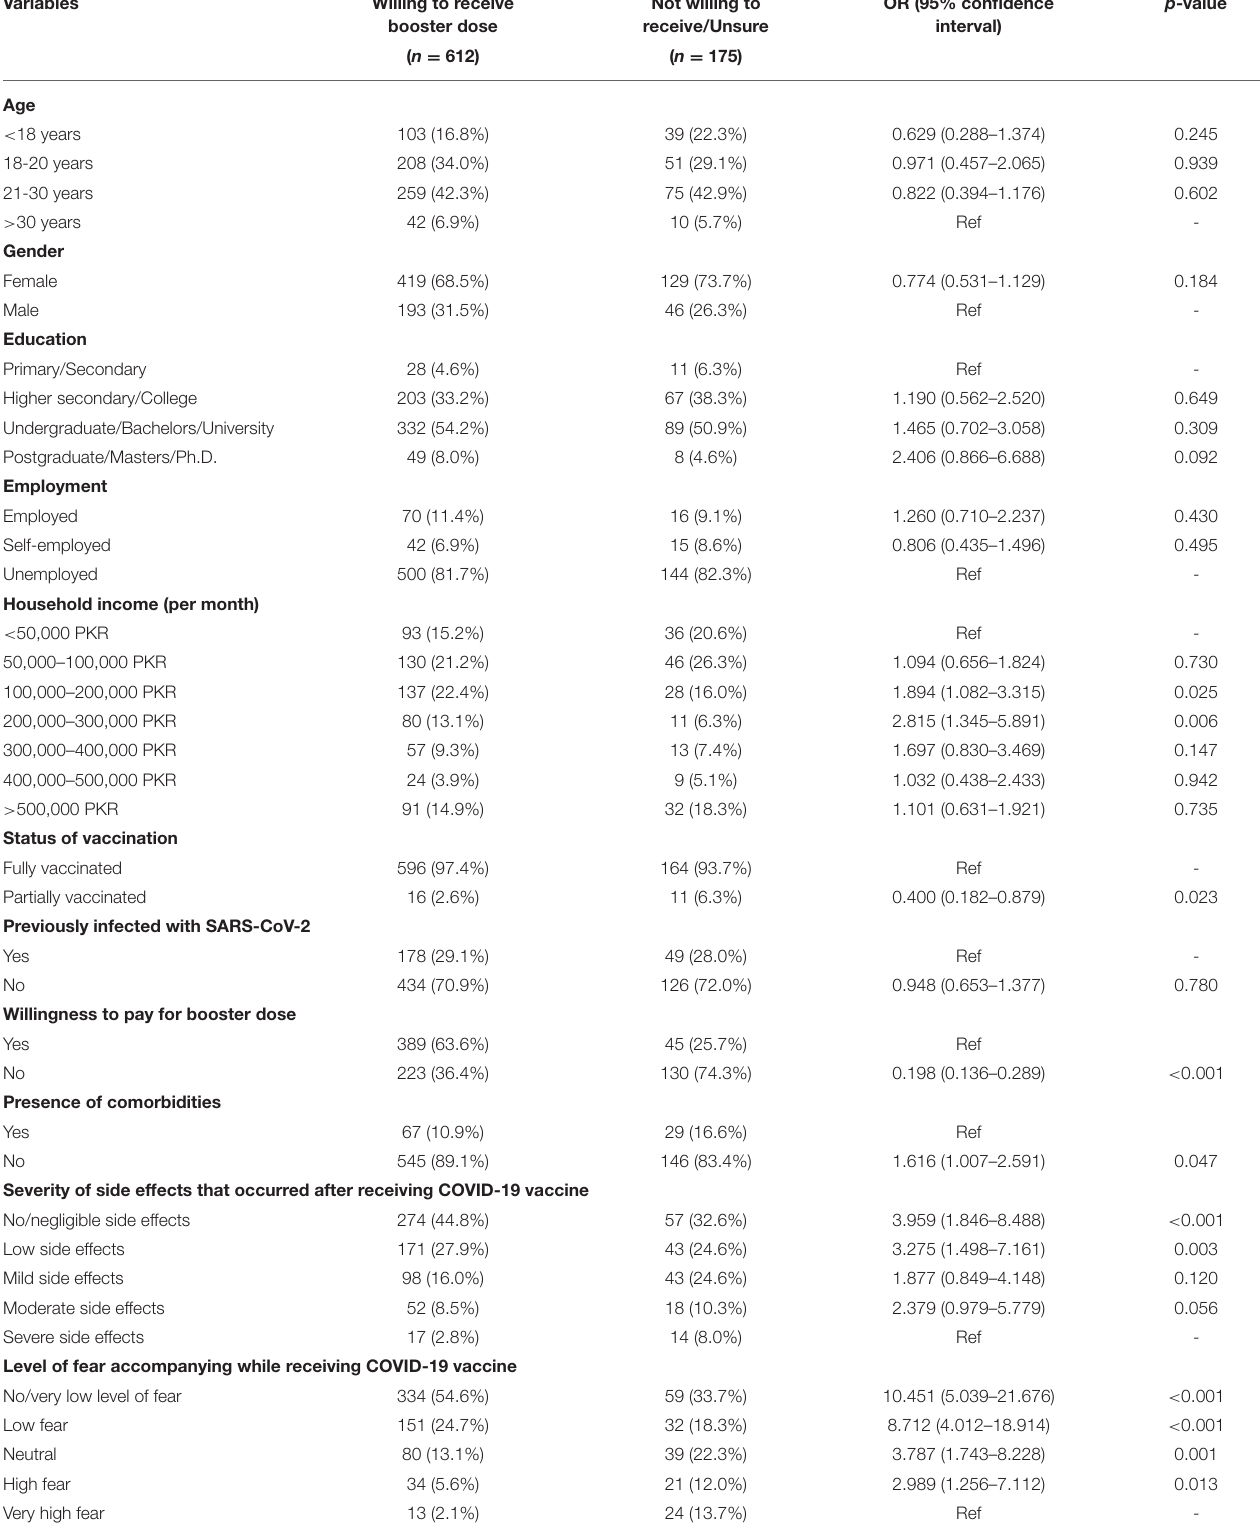
TABLE 3 | Univariable analysis of study variables to willingness of booster dose.